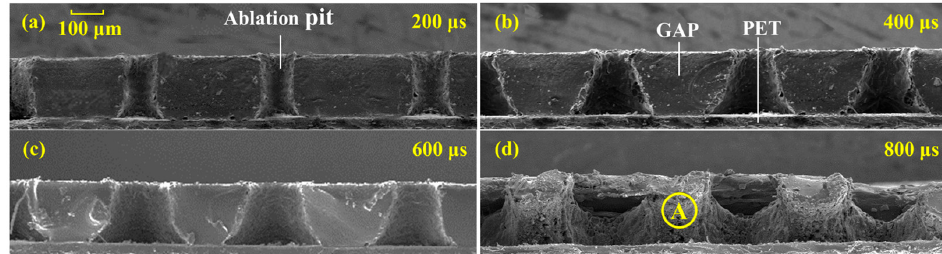
Figure 12. Morphologies of the ablation pits with different pulse widths. ( a ) The sectional view of three consecutive ablation pits with laser pulse width of 200 μ s; ( b ) The sectional view of three consecutive ablation pits with laser pulse width of 400 μ s; ( c ) The sectional view of three consecutive ablation pits with laser pulse width of 600 μ s; ( d ) The sectional view of three consecutive ablation pits with laser pulse width of 800 μ s.